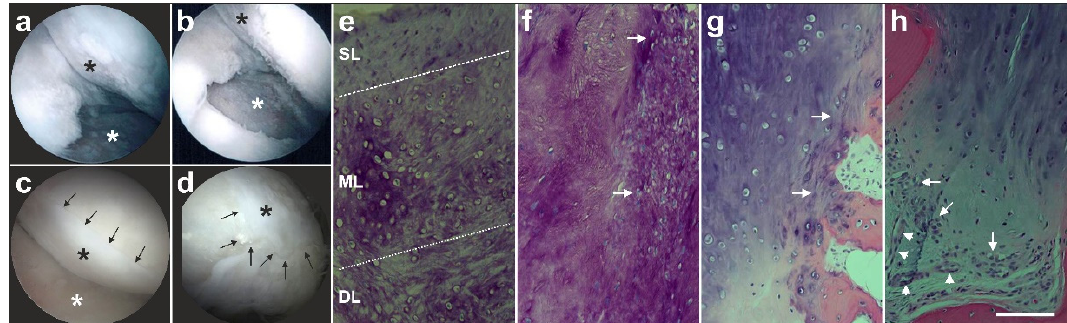
Figure 5. Example of regeneration of knee cartilage with UA-ADRCs (modified from [4]). Details are provided in the main text. The scale bar in h represents 100